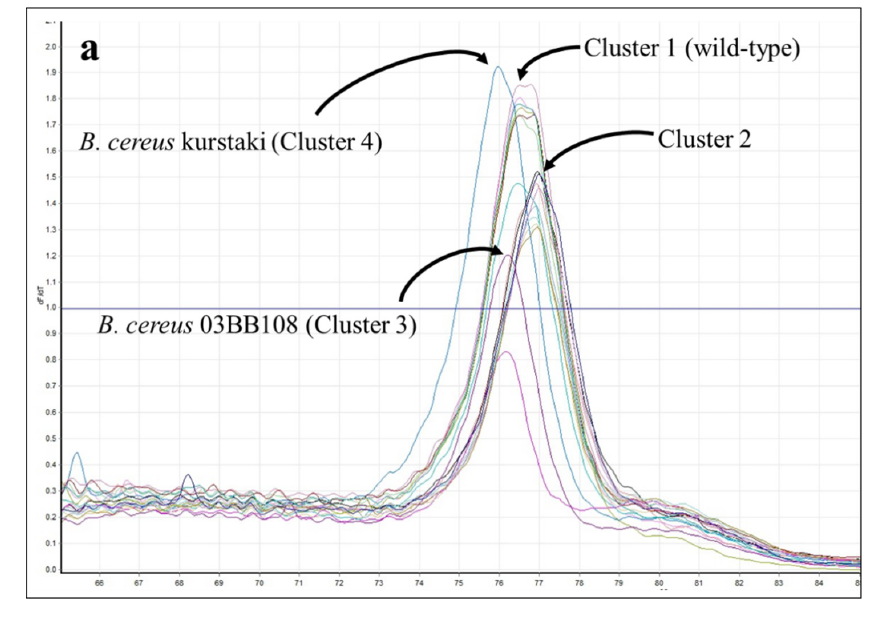
Figure 10. HRMA— B. cereus and B. anthracis gyrA . ( a ) Melt curves for B. cereus and B. thuringiensis gyrA amplicons. ( b ) Comparison of reference gyrA sequence with published sequences for the B. cereus (BC) and B. thuringiensis (BT) strains (see Table 12). Primer sequences are underlined; nucleotide substitutions at the locations shown in red have been documented to cause resistance. Substitutions predicted to increase or decrease amplicon T m s are highlighted in green or yellow, respectively.